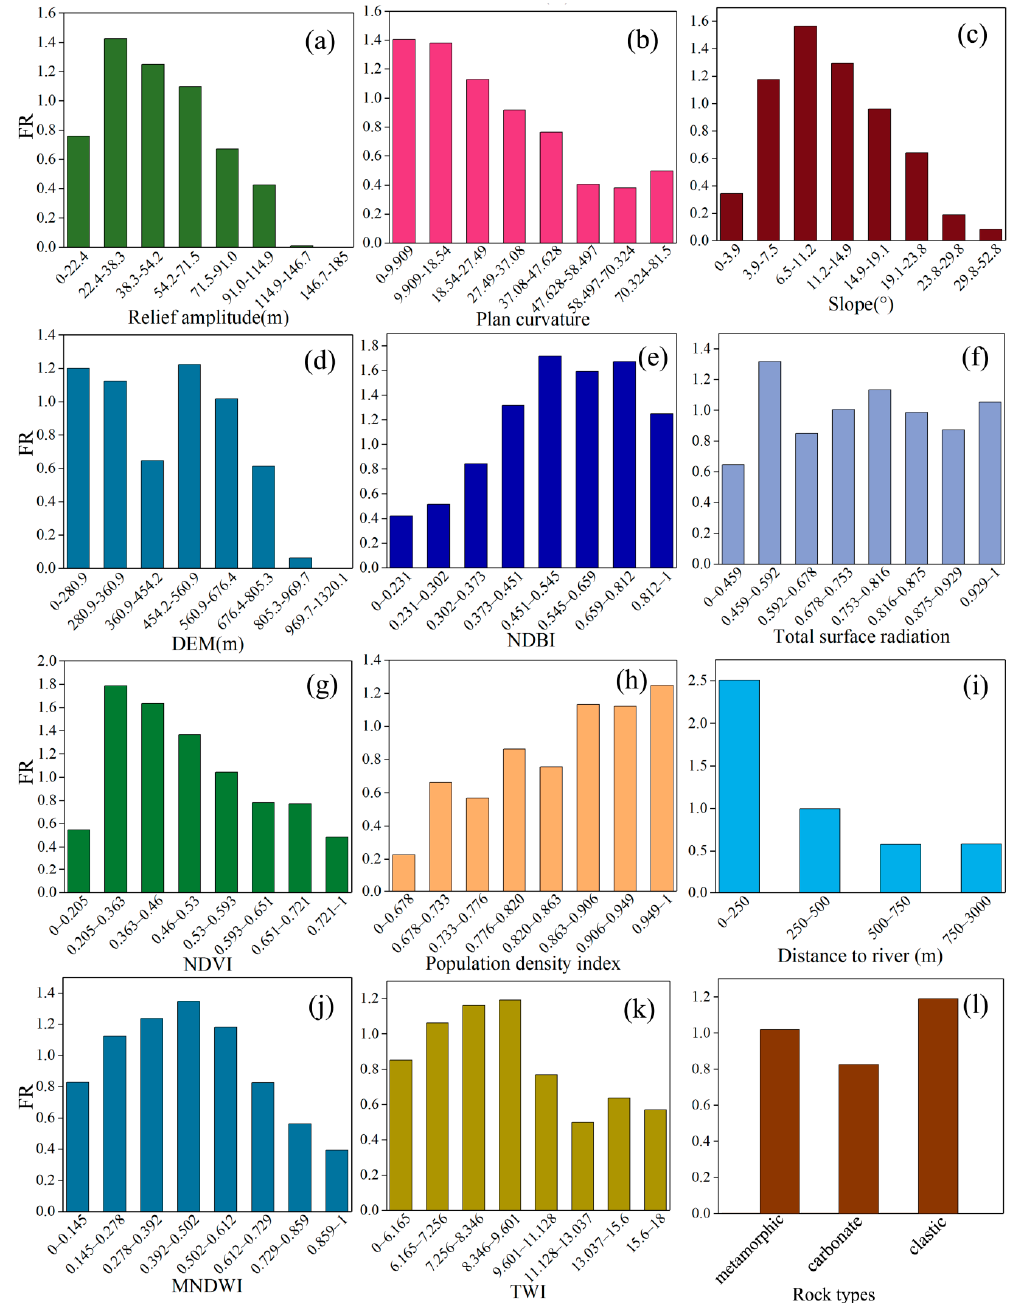
Figure 5. Frequency ratio values of environmental factors (aspect and profile curvature are not presented).